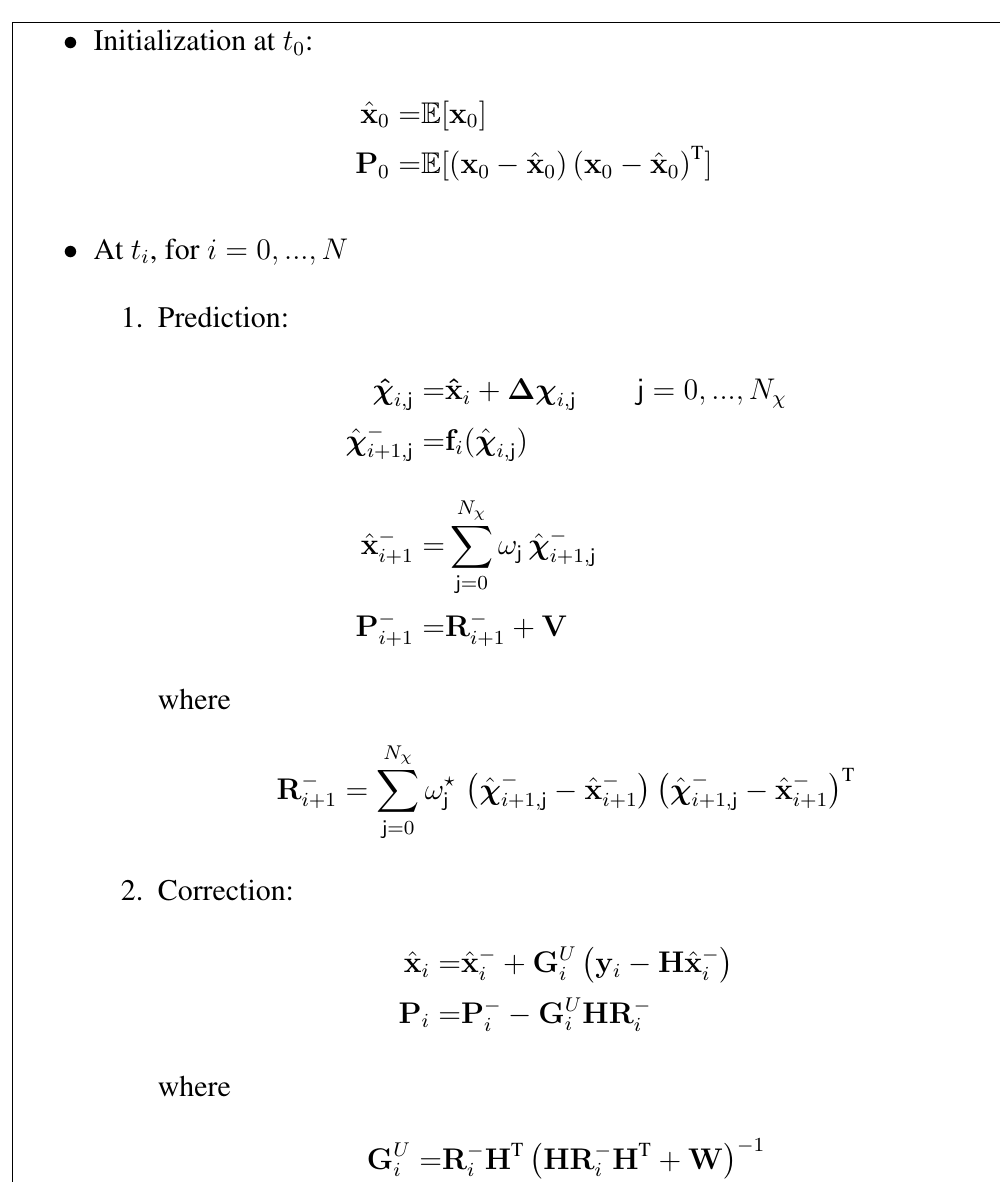
Table 1. Sigma-point Kalman